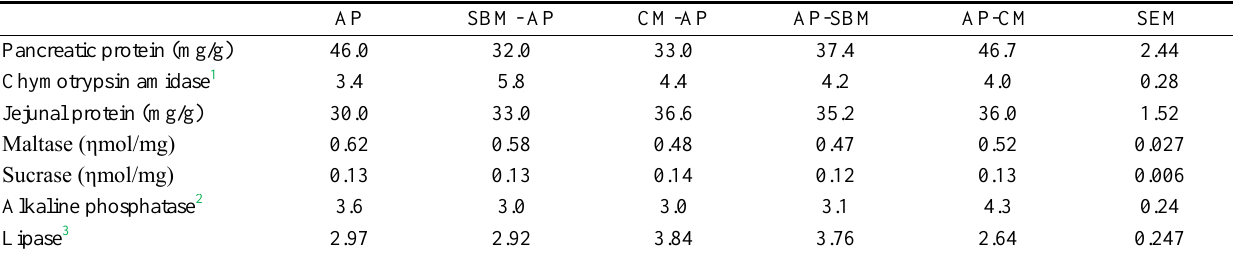
Table 5. Tissue protein and enzyme activities of broiler chicks at 21 days of age on different feeding